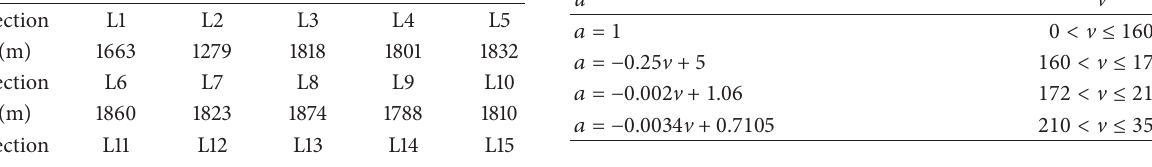
Table 1: The length of downward positive block section of Shaoguan station.